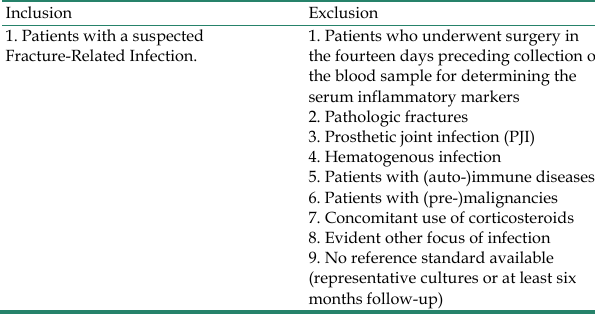
Table 1. Inclusion and exclusion criteria. Inclusion Exclusion 1. Patients with a suspected Fracture-Related